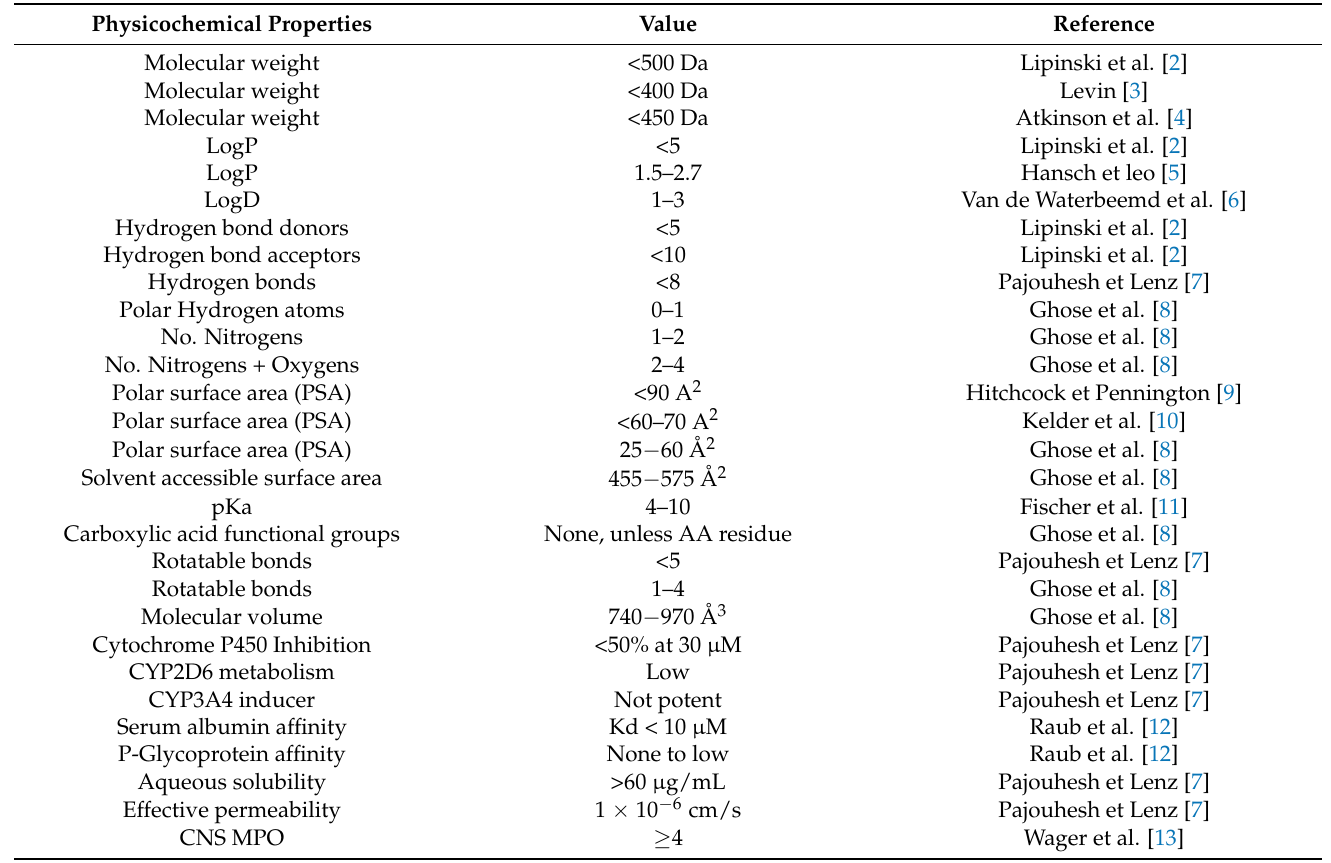
Table 1. Various Parameters for Predicting Small Molecule BBB